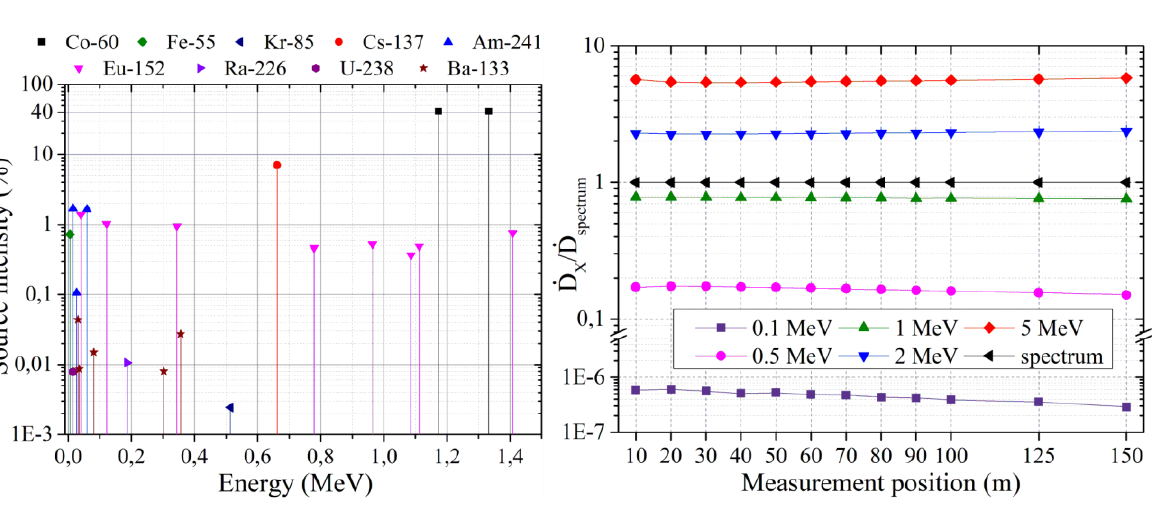
Figure. 3. Source line spectrum (waste from JSI + CIS), presenting relative source intensity in dependence on the energy of the emitted γ - rays (left). The influence of the γ - rays energies on the overall γ - dose rates for 12 measurement positions, whereby the results are normalized to the values obtained by the source spectrum